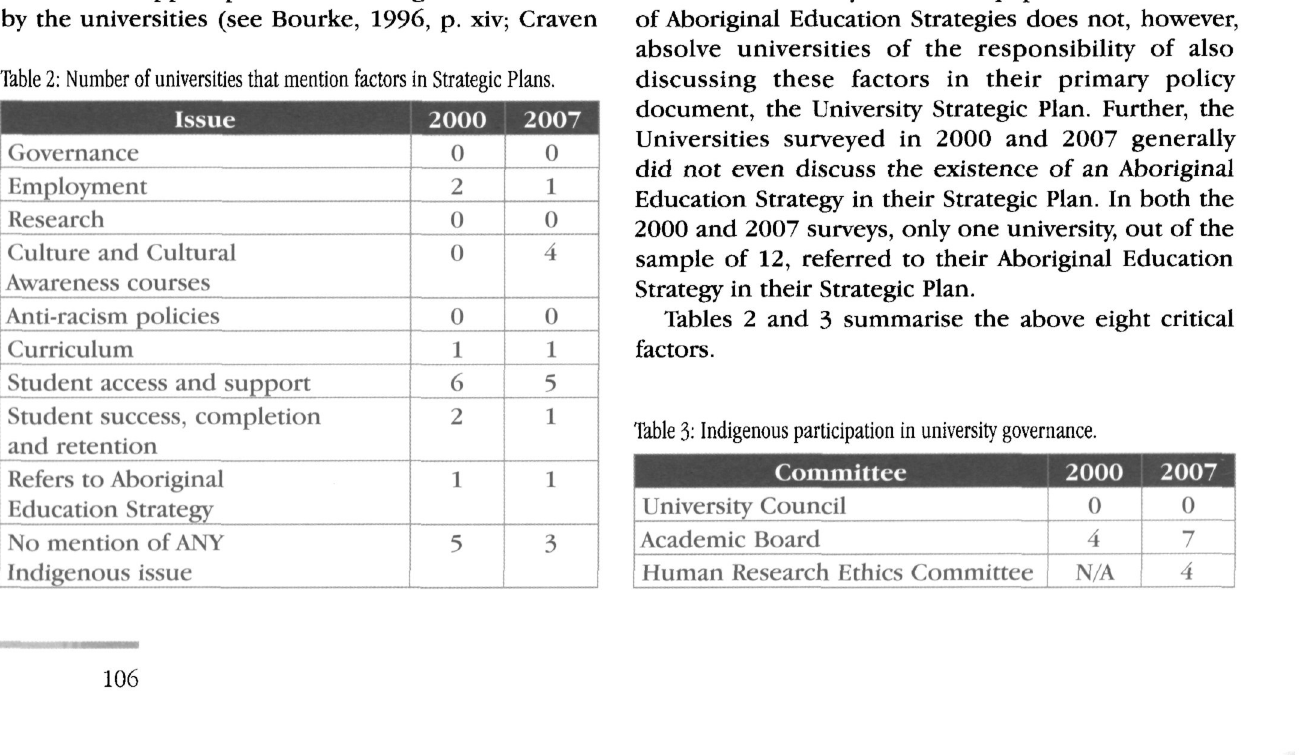
Table 3: Indigenous participation in university